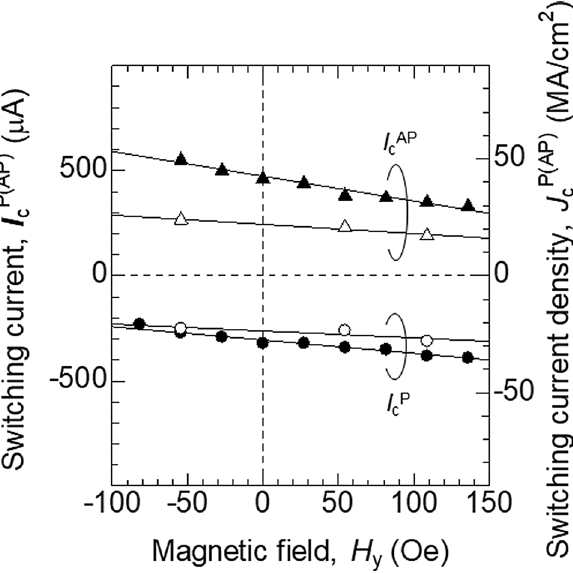
P ( AP ) Figure 2. H y dependence of the switching current I c . The circles and triangles represent the switching P I AP from parallel (P) to antiparallel (AP) states ( I c ) and from AP to P states ( c ), respectively. The solid and open P ( AP ) symbols correspond to I c when pulse current (50 ns long) and DC current (1 s long) are used, respectively. Solid lines represent fitting a linear function to the